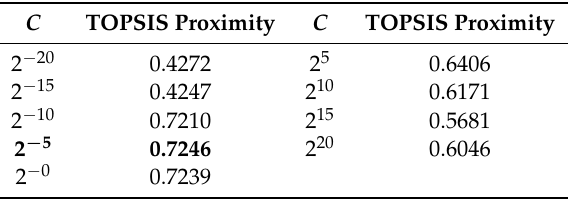
Table 4. TOPSIS proximity under different C .